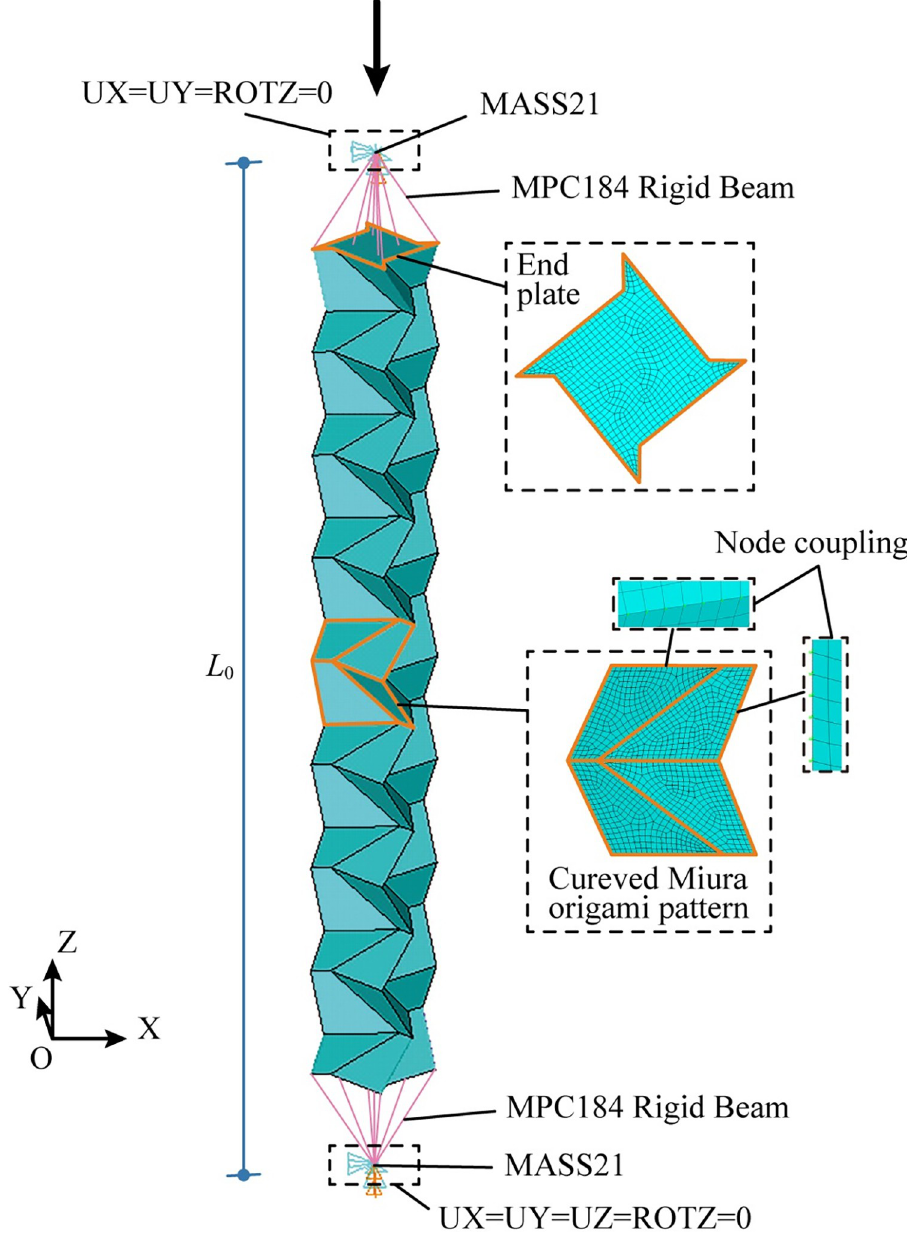
Fig 13. Modelling of an 8-level patterned